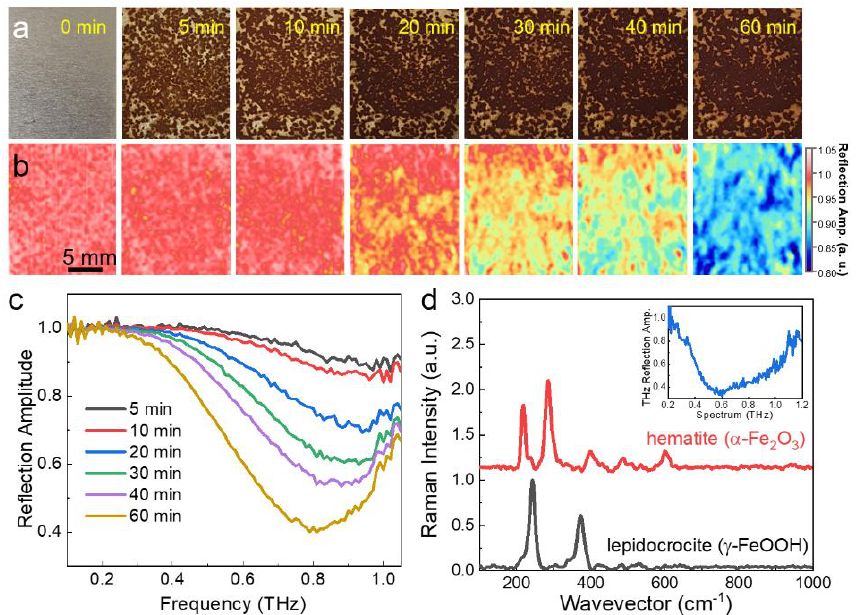
Figure 5. Photograph images ( a ) and rapid THz reflection images ( b ) for different measurement time after it is exposed to acidic solution. ( c ) THz reflection amplitude spectra averaged over the entire region in ( b ) for different measurement time. ( d ) Raman spectra of lepidocrocite and hematite found in our experiments. Inset shows the THz reflection signal from a thick hematite pallet.